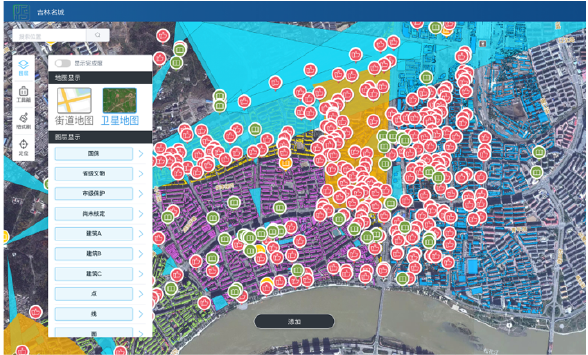
Figure 14 . Collection Results of Jilin Historic